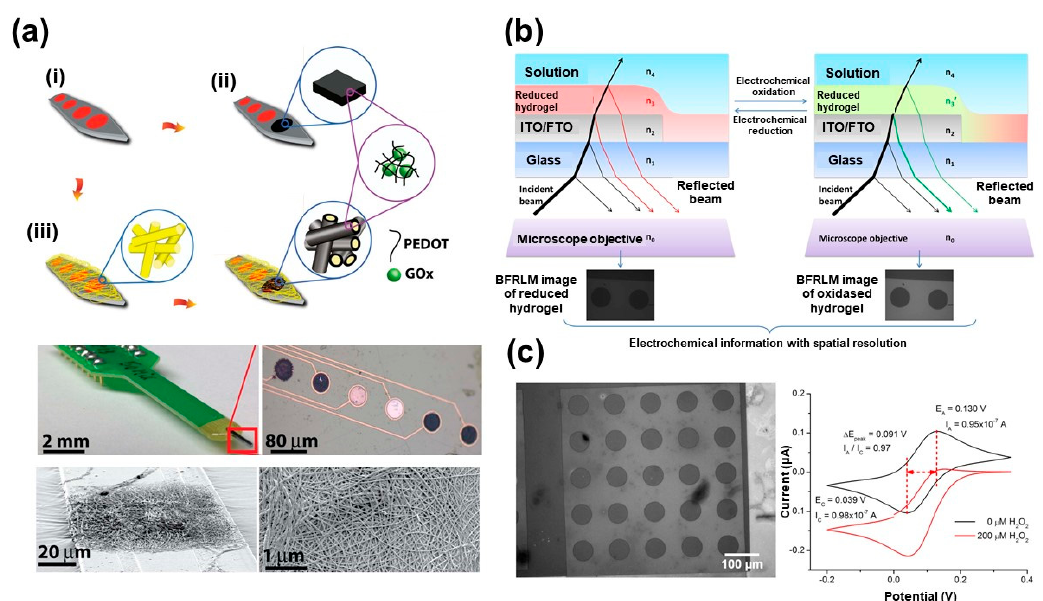
Figure 1. ( a ) Glucose oxidase (GOx)-incorporated PEDOT on the microelectrode array: ( i ) Pt microelectrode array. ( ii ) Electrodeposition of GOx-incorporated PEDOT film (PEDOT F-GOx) with electrospinning of PEDOT nanofibers (PEDOT NFs-GOx), poly(L-lactide) (PLLA) nanofibers on the microelectrode array. ( iii ) Electrodeposition of PEDOT around the PLLA nanofibers to form GOx-incorporated PEDOT nanofibers (PEDOT NF-GOx). Optical and scanning electron microscope (SEM) images of the entire microelectrode array are below Reproduced with permission [30]. Copyright 2014 Wiley. ( b ) Schematics of BFRLM for increasing the spatial resolution of redox hydrogel-based electrochemical biosensors. The incident light is refracted and reflected on the different interfaces of the multilayered sensor [32]. ( c ) Electrochemical detection of hydrogen peroxide using an Fluorine doped Tin Oxide (FTO) electrode modified with horseradish peroxidase (HRP)-based redox hydrogel [32].